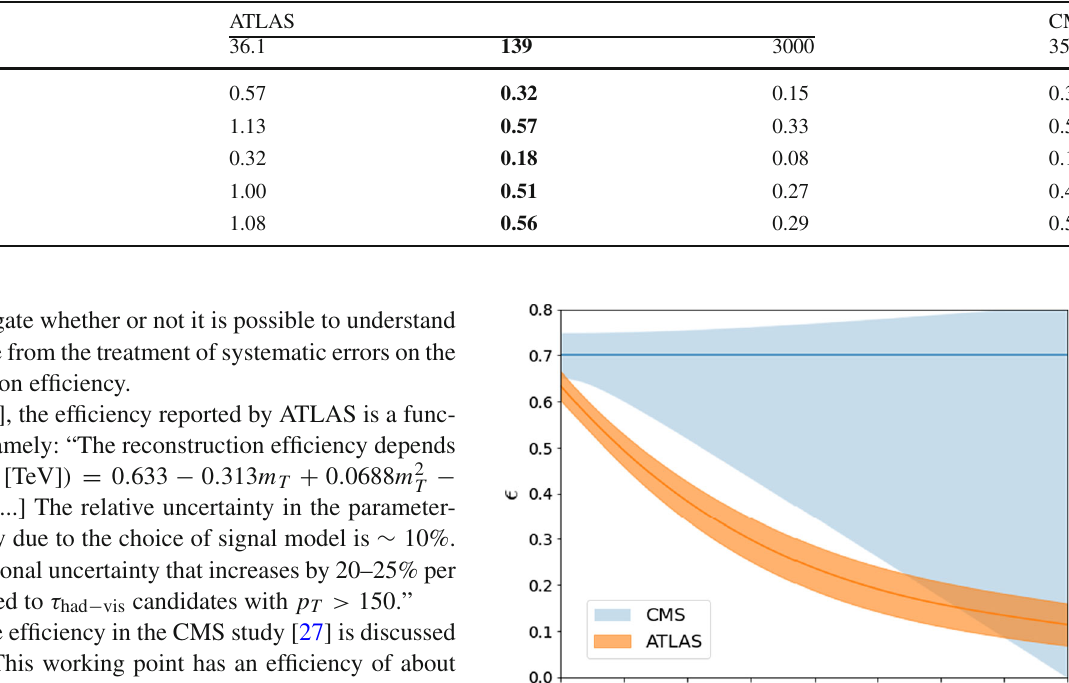
Table 1 Upper limits on the individual Wilson coefficients at μ = m b using the ATLAS data with 36 and 139 fb − 1 , respectively [24,26] and neglecting the systematic uncertainty on the τ reconstruction efficiency, as done in Refs. [20,21]. Projection to 3 ab − 1 is also quoted, using the